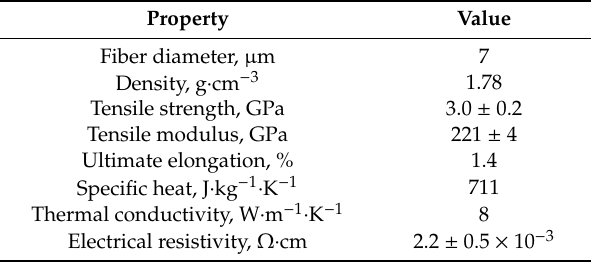
Table 1. Physical and mechanical properties of PAN-type carbon fibers.